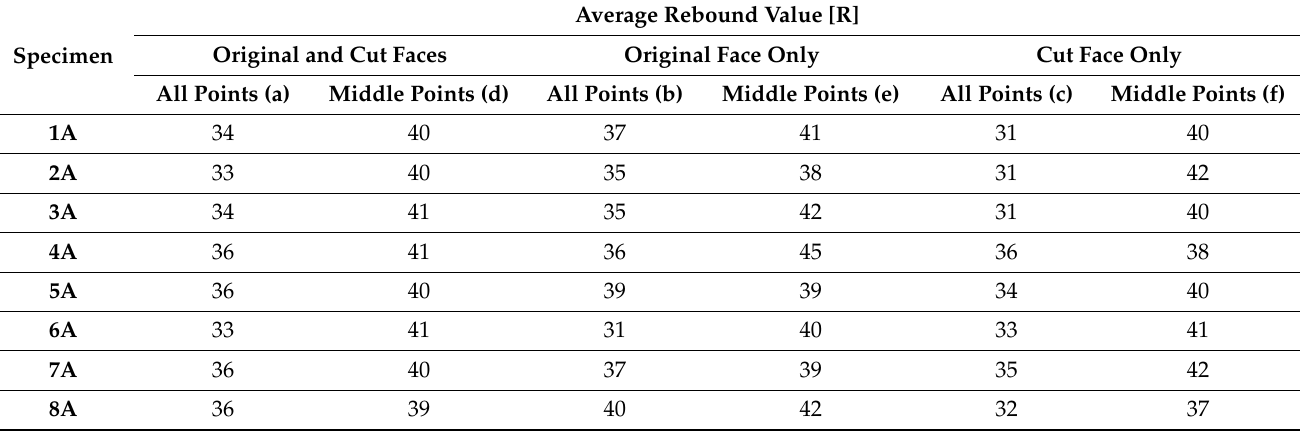
Table 5. Average rebound hammer